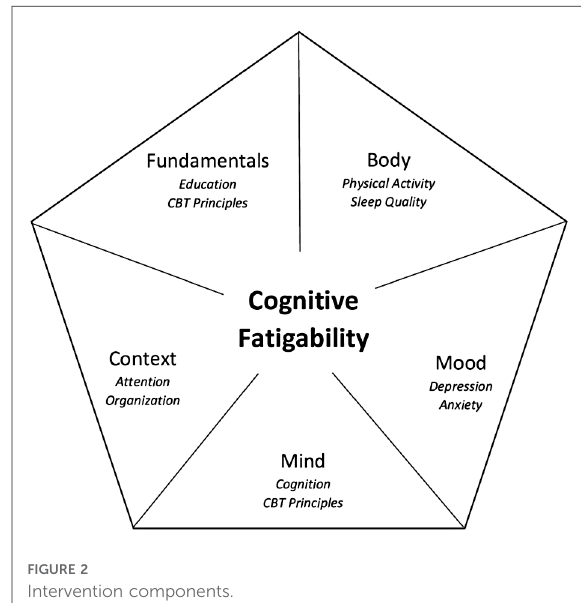
FIGURE 2 Intervention components.